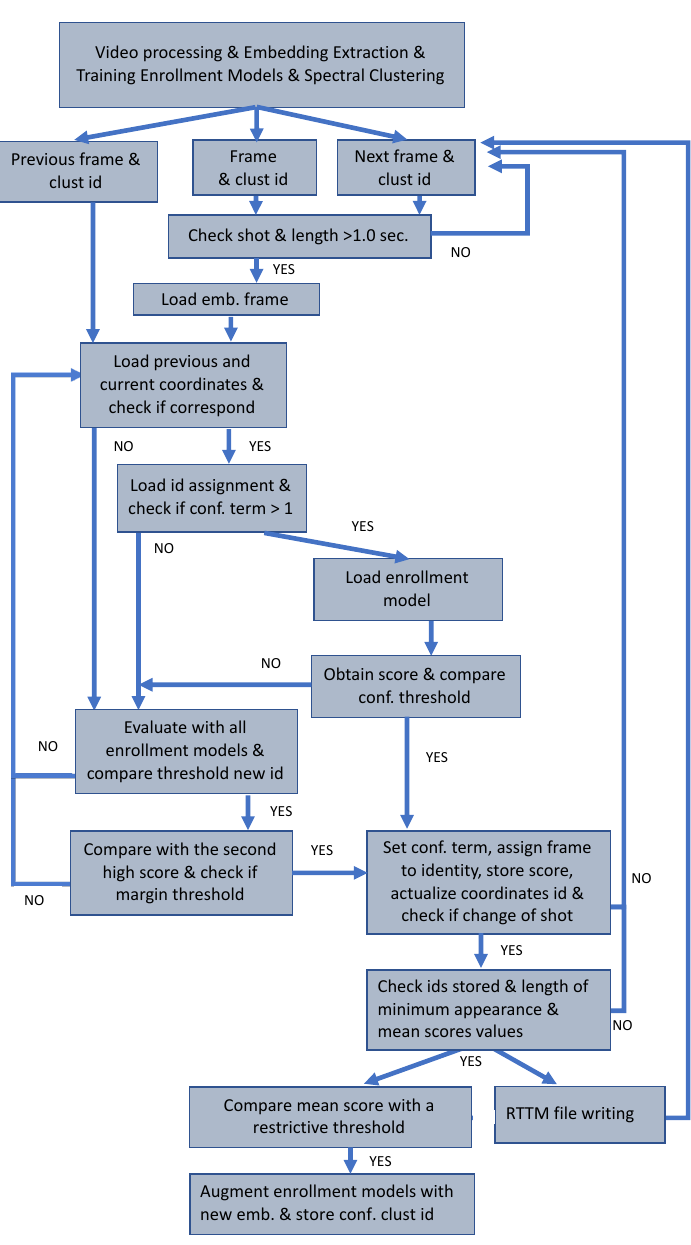
Figure 2. Block diagram of face